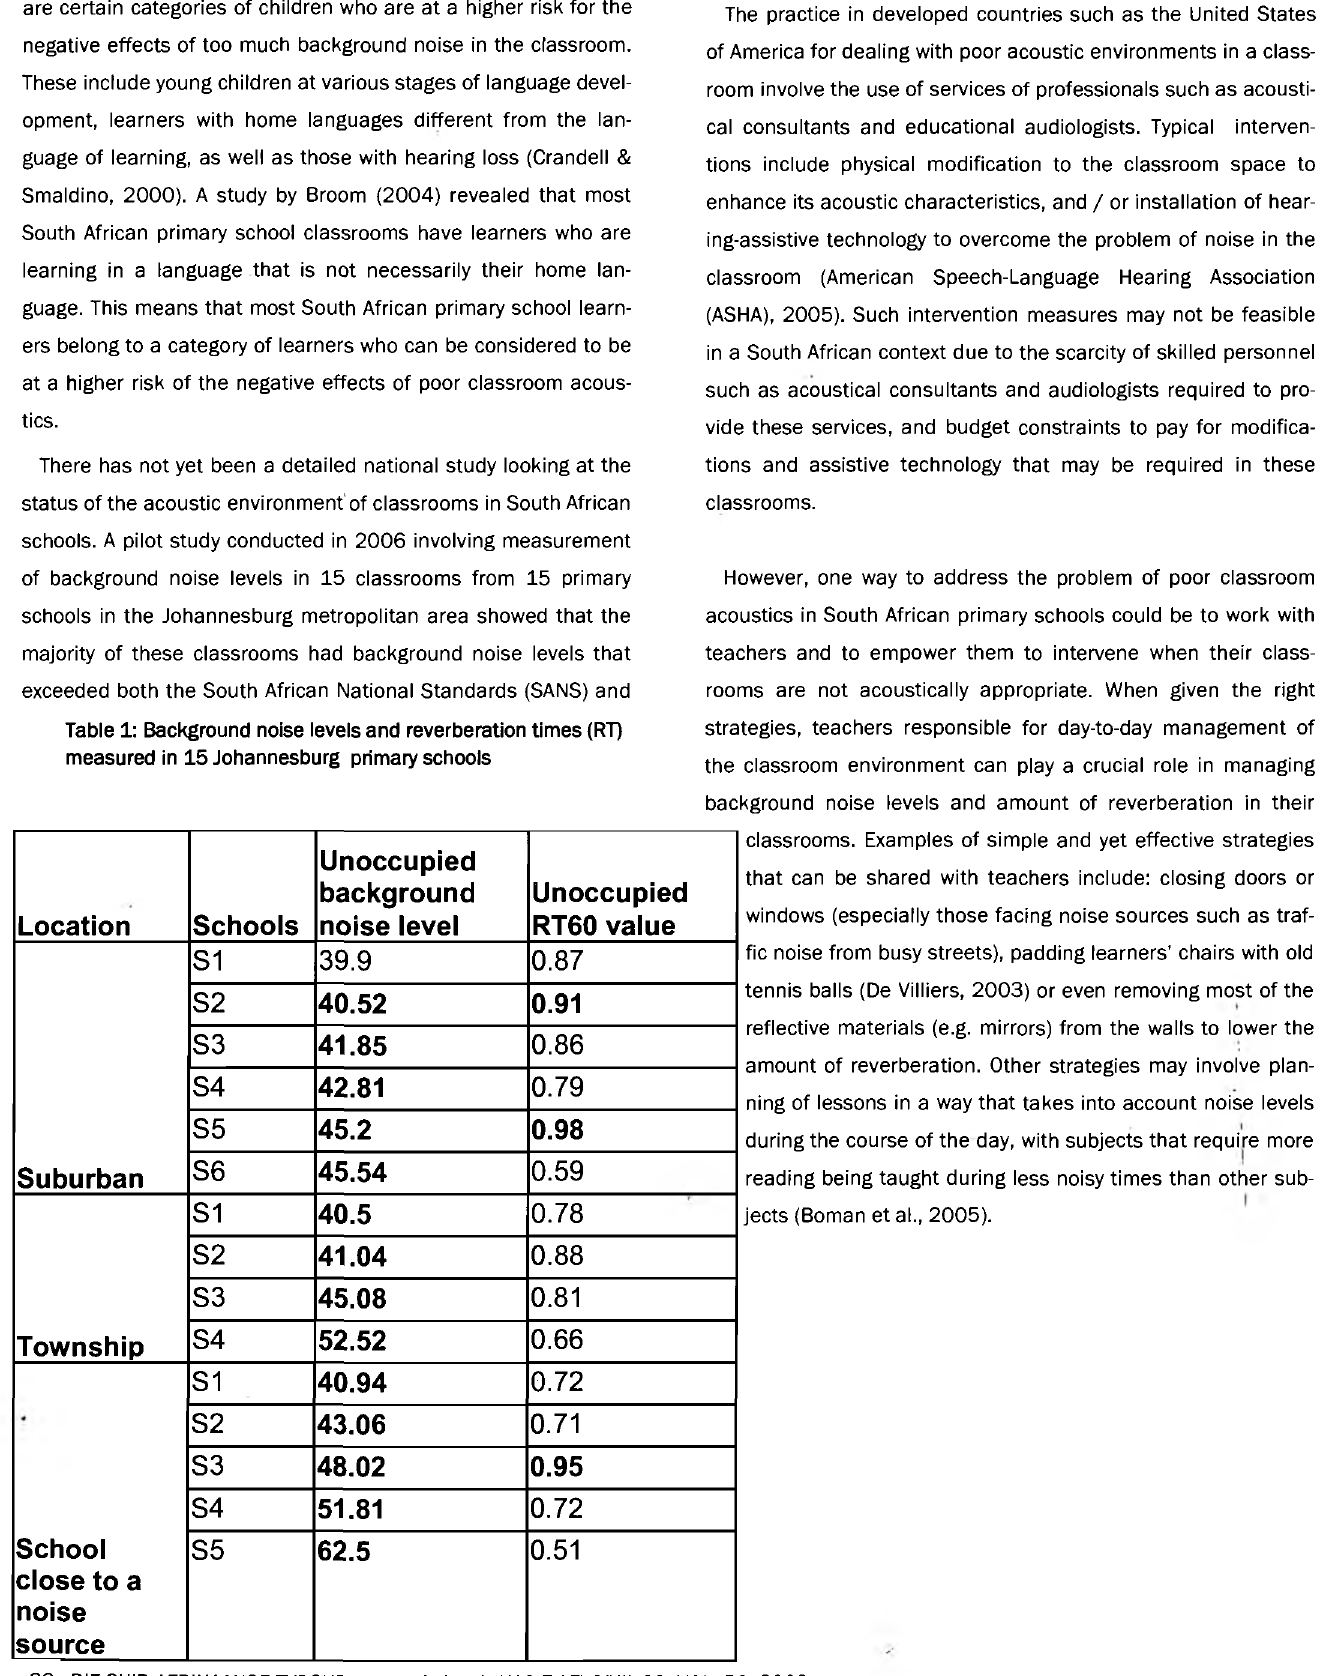
Table 1: Background noise levels and reverberation times (RT) measured in 15 Johannesburg